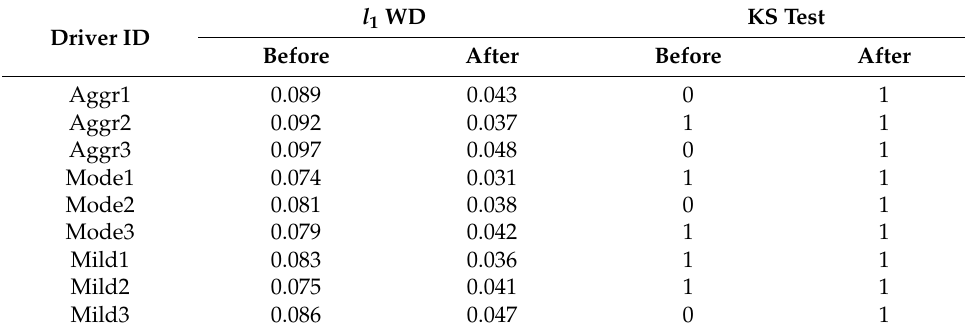
Table 3. Consistency statistics among three styled